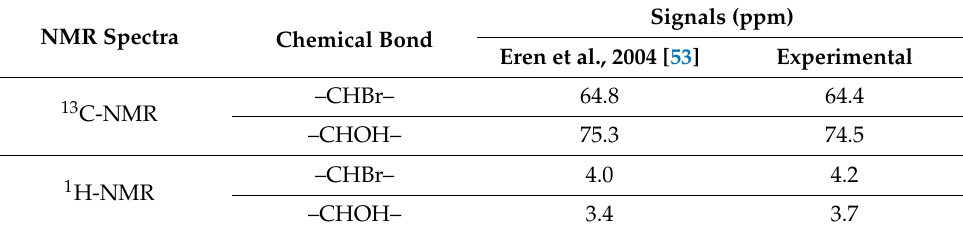
Table 3. Signals that Corroborate the Formation of a Bromohydrin as a Side Product of the Carbona- tion Reaction of ELO (Run 4, 120 ◦